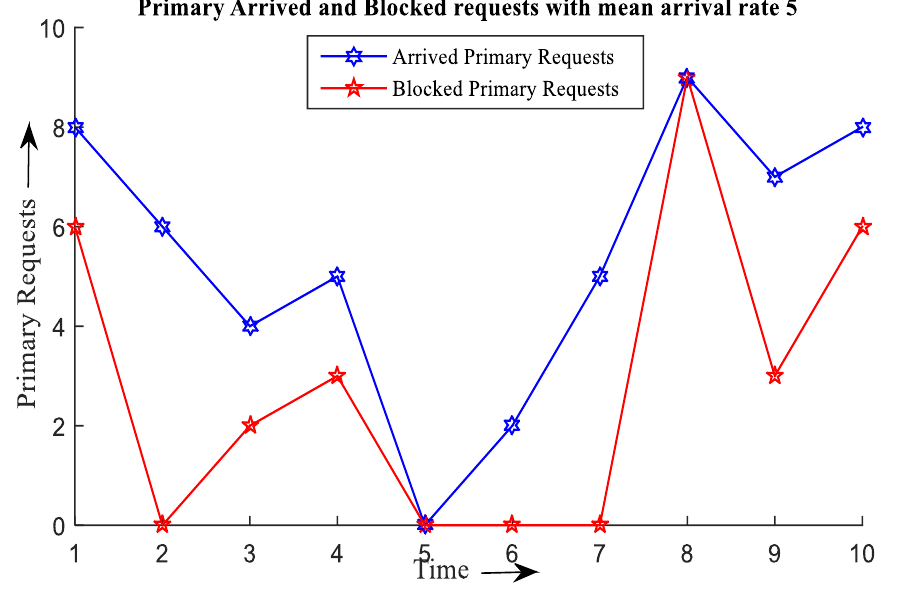
Figure 3. Primary arrived and blocked requests ( λ = 5